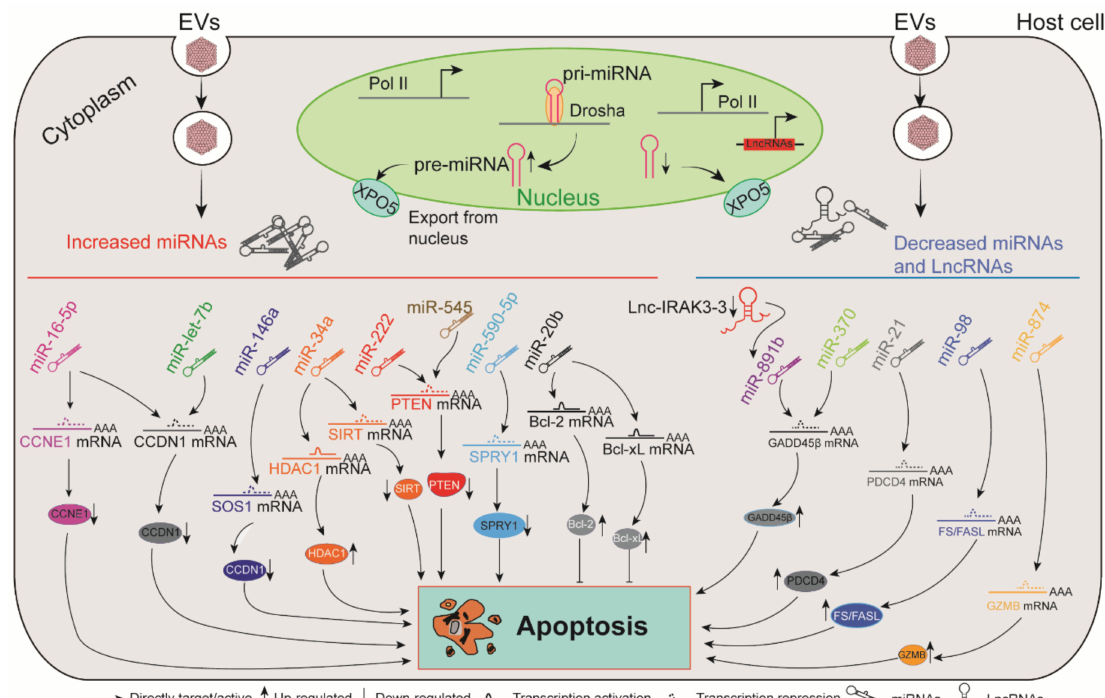
Figure 2. The critical roles of ncRNAs in EV-induced apoptosis. After EV invasion, dysregulated ncRNAs induced by viral infection affect the host apoptotic process by targeting apoptosis-related